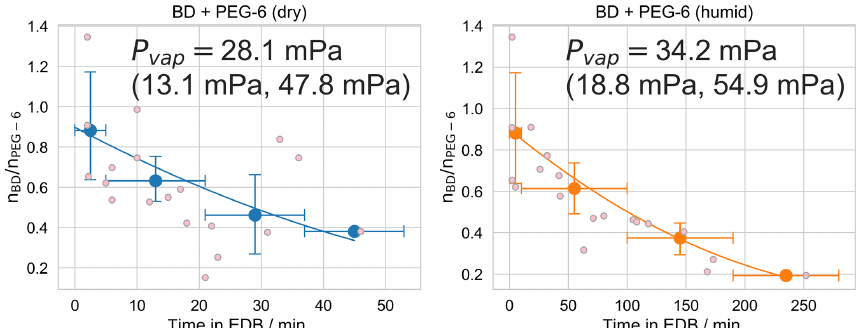
Figure 6. Experiments used to determine the effective vapor pressure of butenedial (BD) in a droplet also containing hexaethylene glycol (PEG-6), under dry (RH < 5%) and humid (RH 75 ± 5%) conditions. Small pink points are observations of individual droplets and the line is the best model fit, as described in the text. Large points are the mean binned values from the bootstrapping procedure, with x error bars showing the width of the bins and y error bars representing a 95% confidence interval of the mean value in the bin, over all bootstrapped realizations. The plotted model fit is for the mean vapor pressure obtained by averaging over all model fits to all realizations. The vapor pressure is reported as a 95% confidence interval over repeating the fitting procedure over 10000 bootstrapped